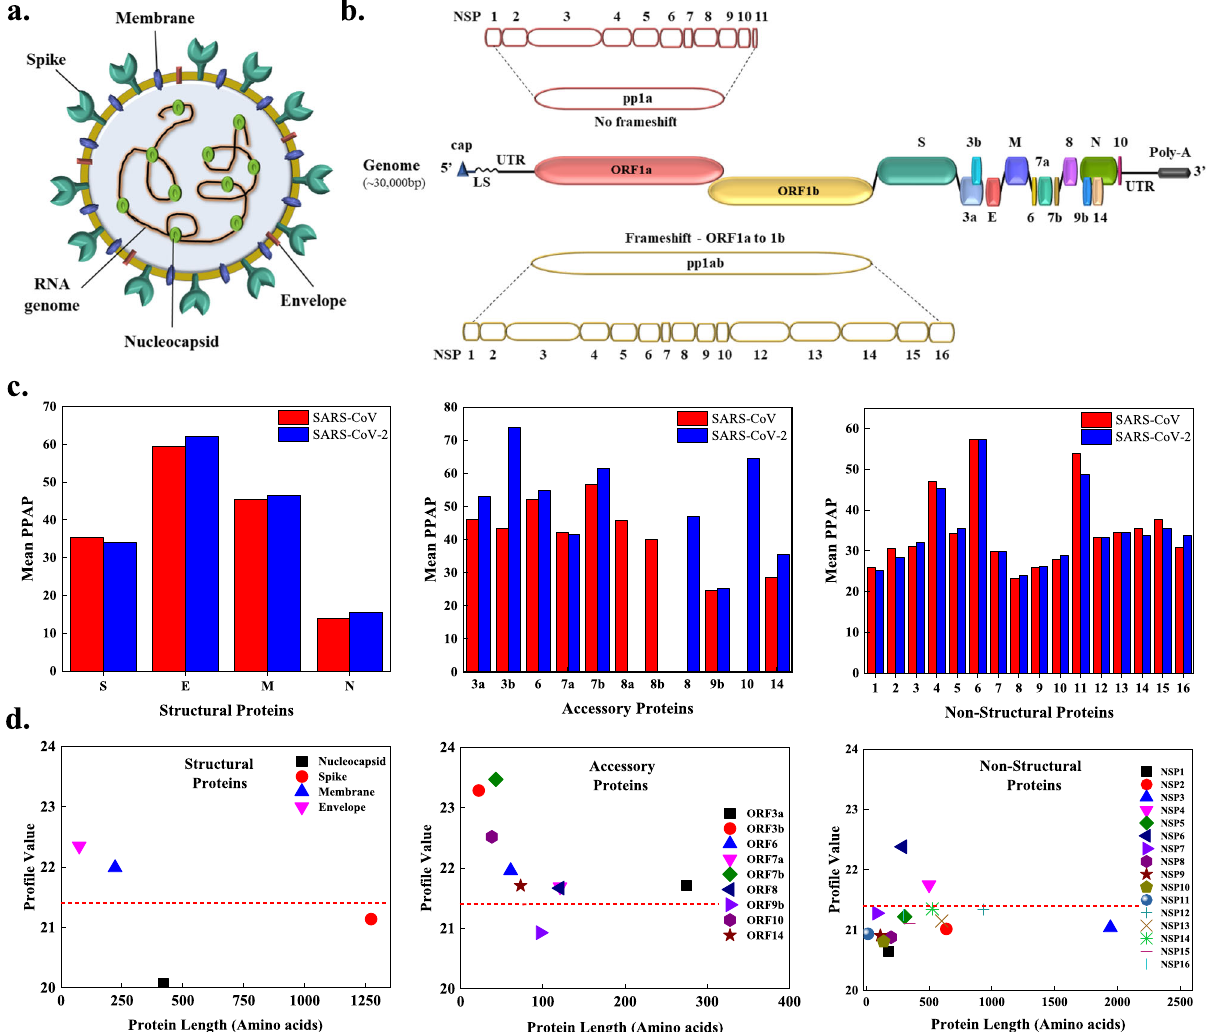
Fig. 1 | Schematic illustration of the organization of genome and proteome of SARS-CoV-2 and aggregation propensity analysis of the SARS-CoV and SARS- CoV-2 proteomes. a The SARS-CoV-2 viral particle comprises of positive-sense single-stranded RNA, which is associated with the nucleocapsid protein (N), and threesurfaceproteins,spike(S),membrane(M),andenvelope(E),embeddedinthe lipid bilayer. b The ~30kbp long genome of SARS-CoV-2 encodes for four struc- tural, nine accessory, and sixteen non-structural proteins (NSPs). c Comparison of mean predicted percentage aggregation propensity (PPAP) calculated using the